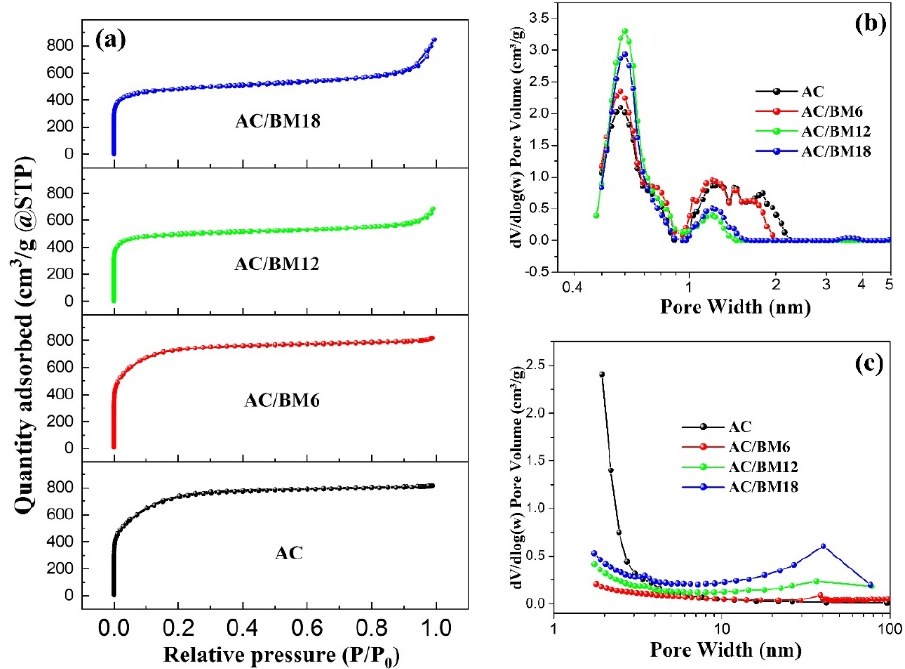
Figure 4. ( a ) N 2 adsorption–desorption isothermal curves, ( b ) micropore-size distribution and ( c ) mesopore-size distribution of AC, AC/BM6, AC/BM12 and AC/BM18. Table 1. Porous structural parameters of AC, AC/BM6, AC/BM12 and AC/BM18 samples.